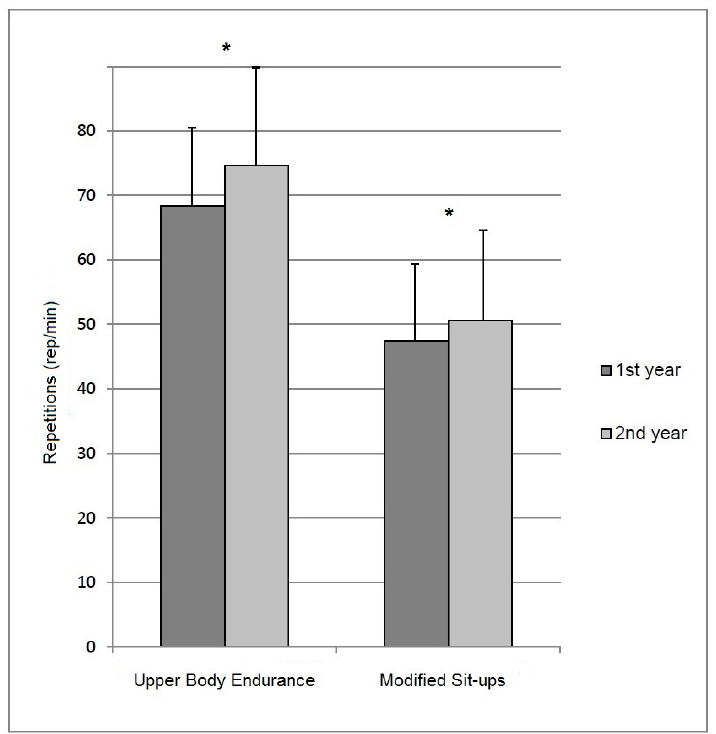
Figure 2. Mean (SD) maximal dynamic muscle strength of the upper limb and trunk flexor muscles during the first and second academic year. * p < 0.05.